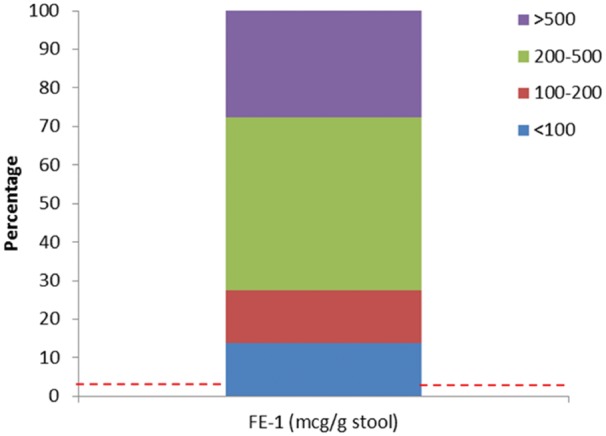
Bar chart showing the percentage of individuals with HNF1B-associated disease with faecal elastase-1 (FE-1) measurements <100 μg/g stool (suggestive of severe pancreatic exocrine insufficiency), 100–200 μg/g stool (moderate to mild insufficiency), 200–500 μg/g stool and >500 μg/g stool. The dotted red line indicates that 3/99 (3%) healthy controls had an FE-1 measurement of 200–500 μg/g stool whereas in the remainder it was >500 μg/g stool.